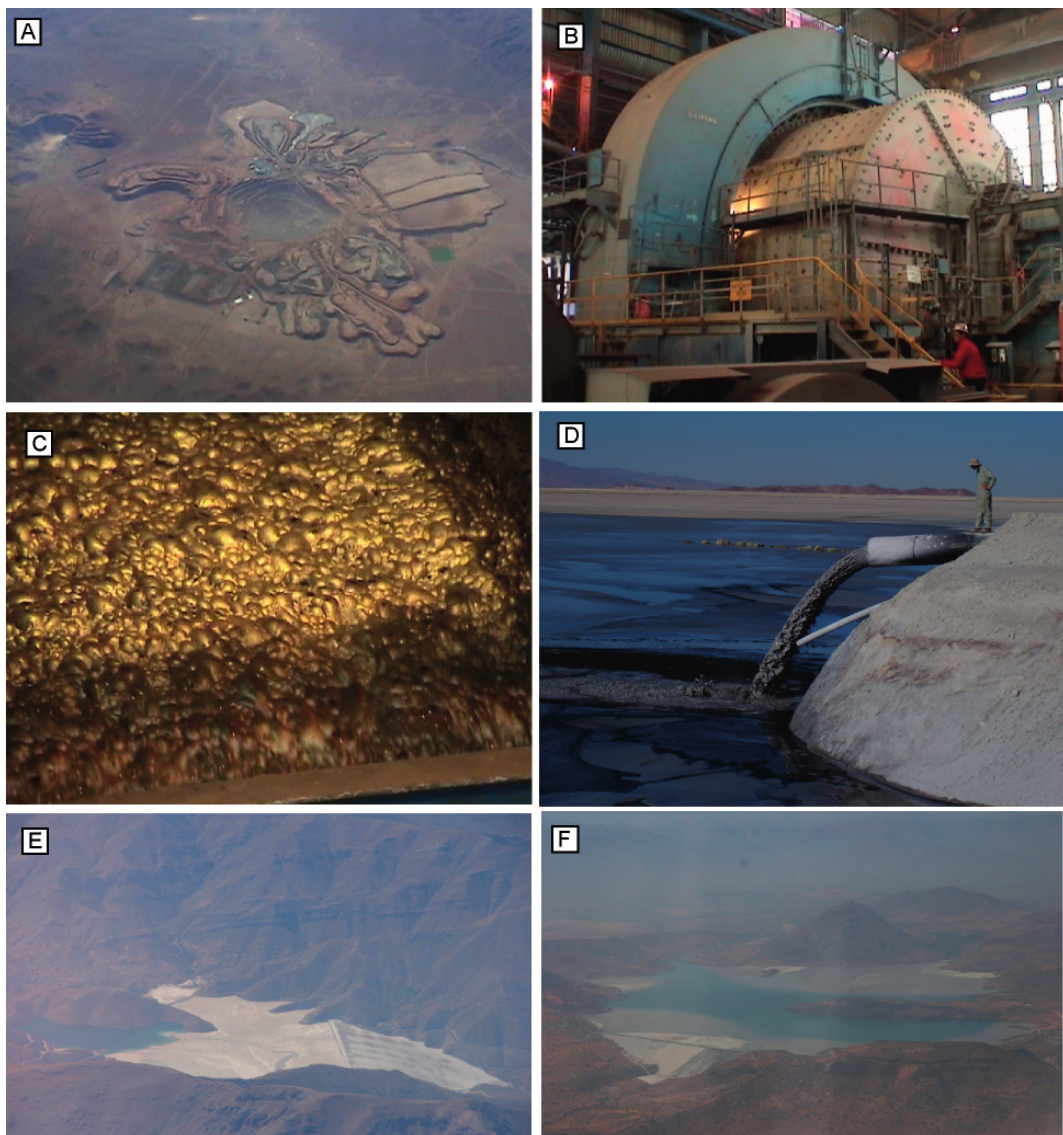
1. ( A ) Open pit mine surrounded by waste dumps and stock-piles. ( B ) Semi-Autogenous Grinding (SAG) mill. ( C ) Froth flotation of chalcopyrite concentrate. ( D ) Deposition point of a tailings impoundment. ( E ) Areal photograph of a valley dam tailings impoundment. Note the slight saturation of the tailings and the seepage in the dam (dark humid spots in the dam). And ( F ) areal view of a big tailings impoundment with near complete water